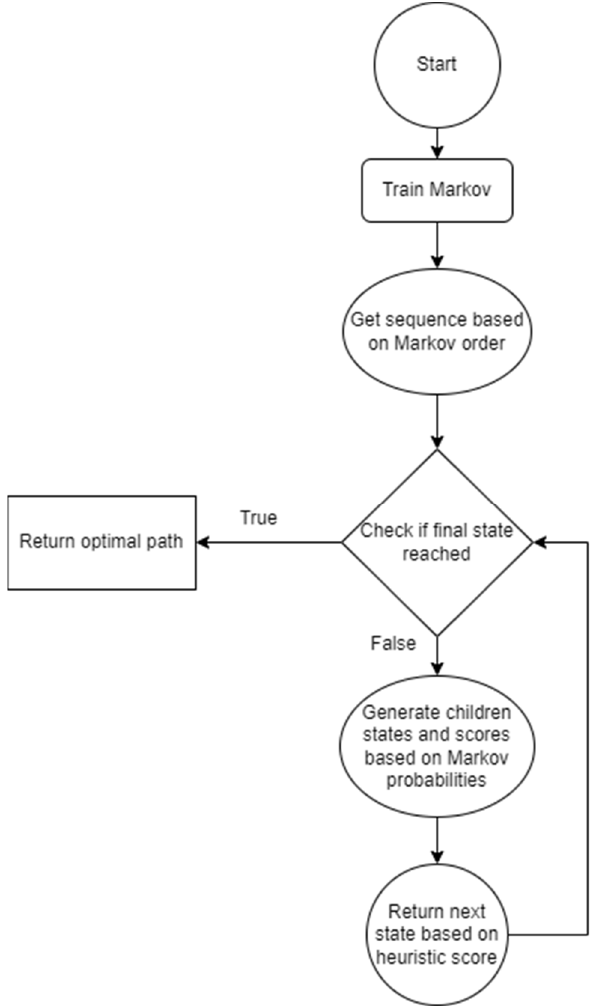
Figure 5. Prediction pipeline and data flow of the